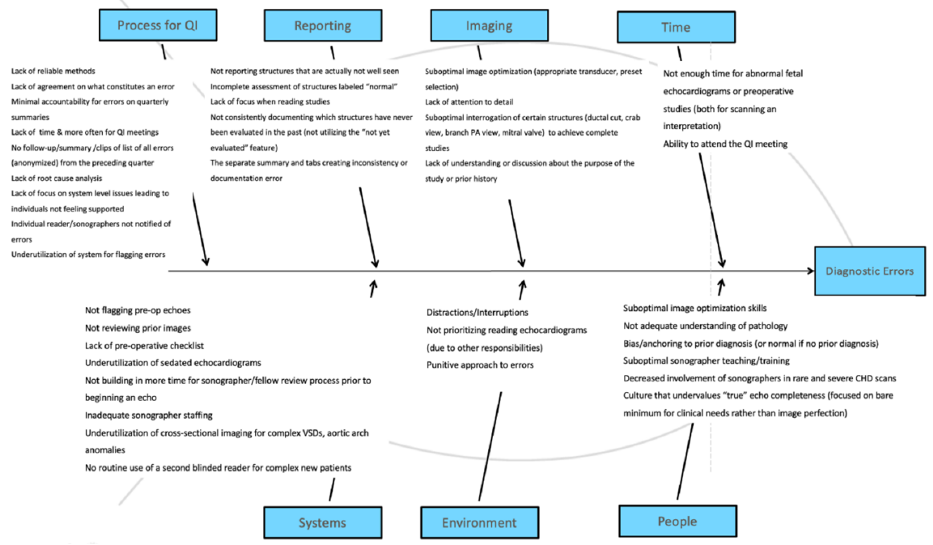
Figure 2. Fishbone diagram. This diagram depicts faculty and sonographer fellow responses, ana- lyzed and grouped into seven categories that may contribute to diagnostic TTE errors.